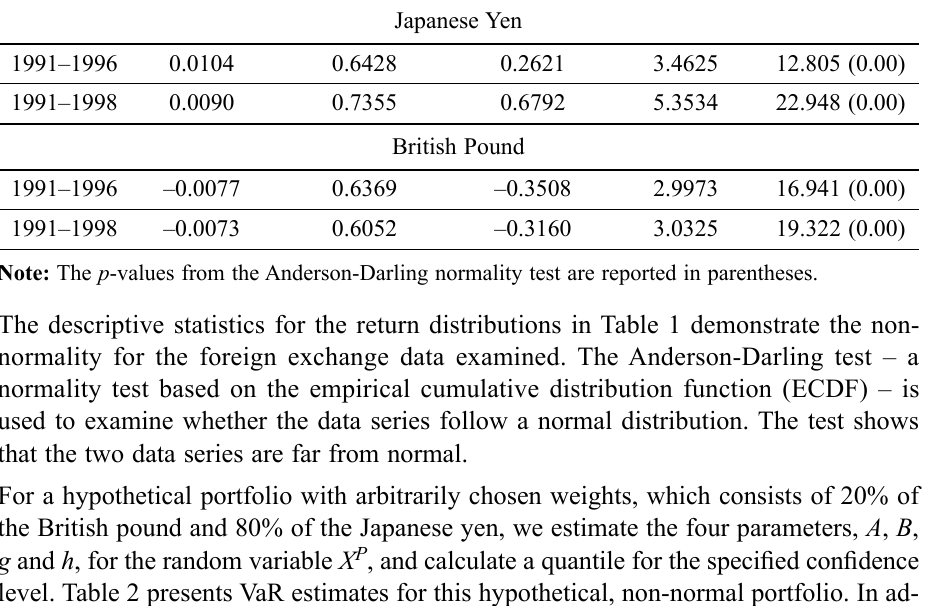
Table 2. Estimation of portfolio VaR and performance